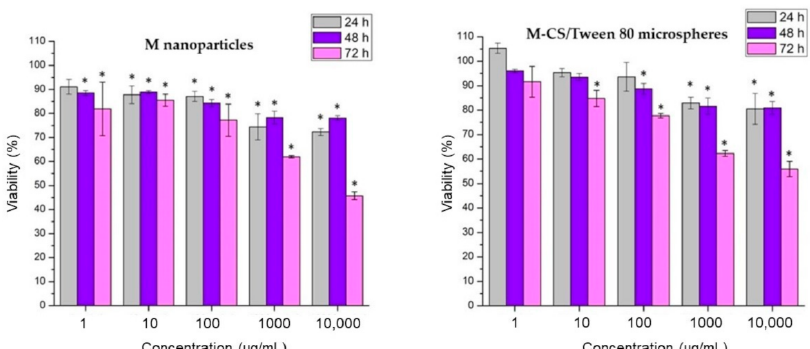
Figure 7. MTT assay of bare magnetite nanoparticles and chitosan/tween 80 microspheres loaded with magnetite nanopar- ticles. There is a significant difference * of particles cytotoxicity concerning negative